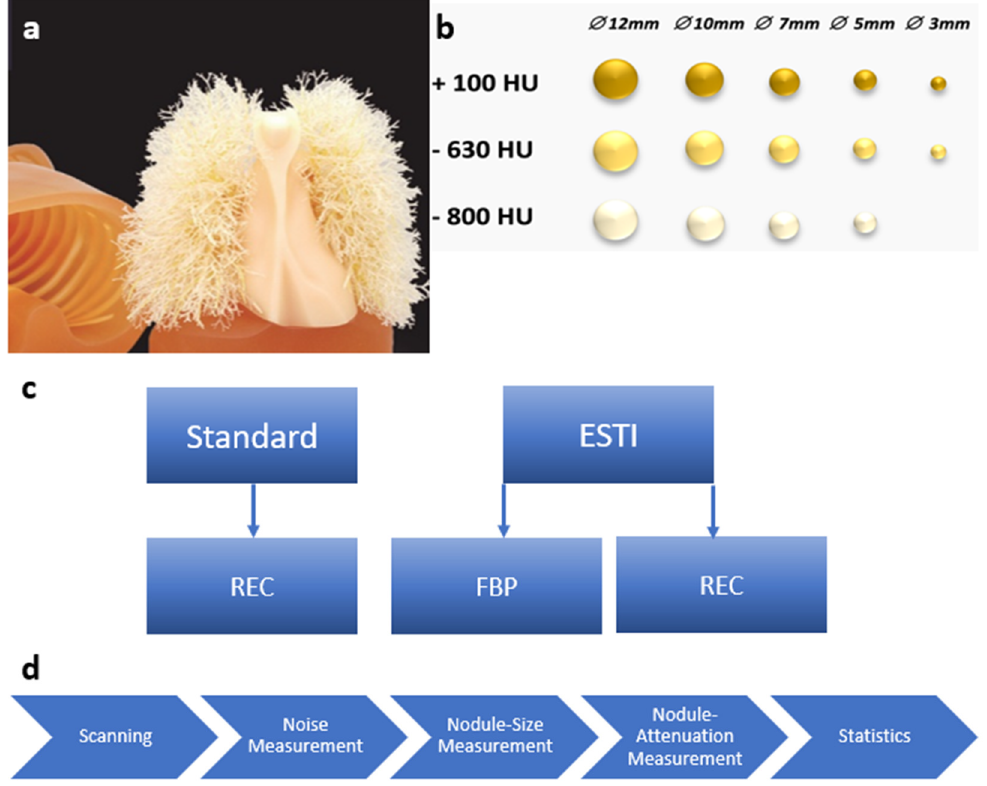
Figure 1. ( a ) Photo of the anthropomorphic chest phantom (Lungman Phantom, Kyoto Kagaku Co. LTD, https://www.kyotokagaku.com/en/products_data/ph-1_01/), access date: 7 February 2023. ( b ) Schematic overview of the lung nodules which were randomly placed in the phantom. ( c ) Scheme of scanning protocols with respective reconstructions. ( d ) Flow-chart of data processing and evaluation. Hounsfield units (HU). Filtered back Projection (FBP). Vendor-specific advanced reconstruction algorithm (REC). European Society of Thoracic Imaging (ESTI).